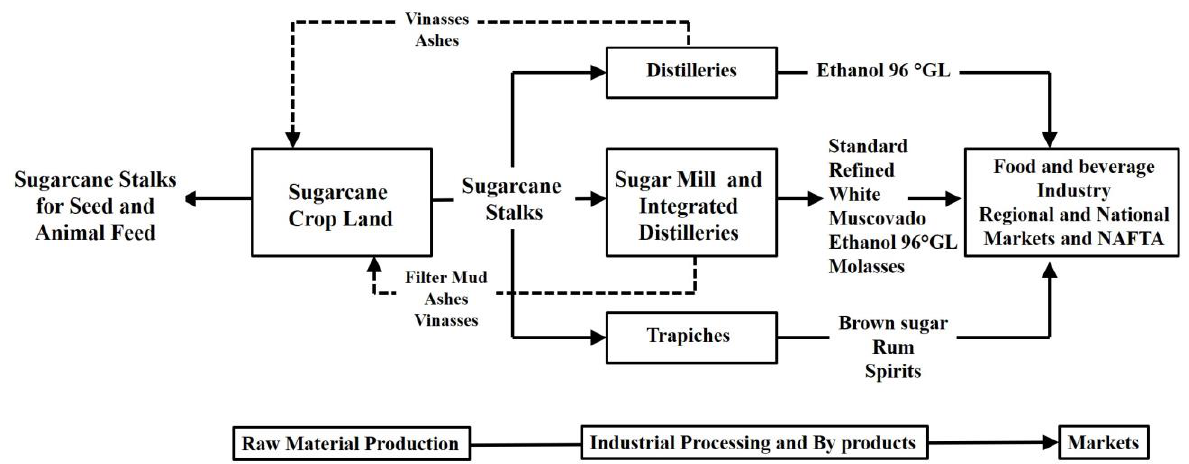
Fig. 4. Productive structure of the Mexican sugar